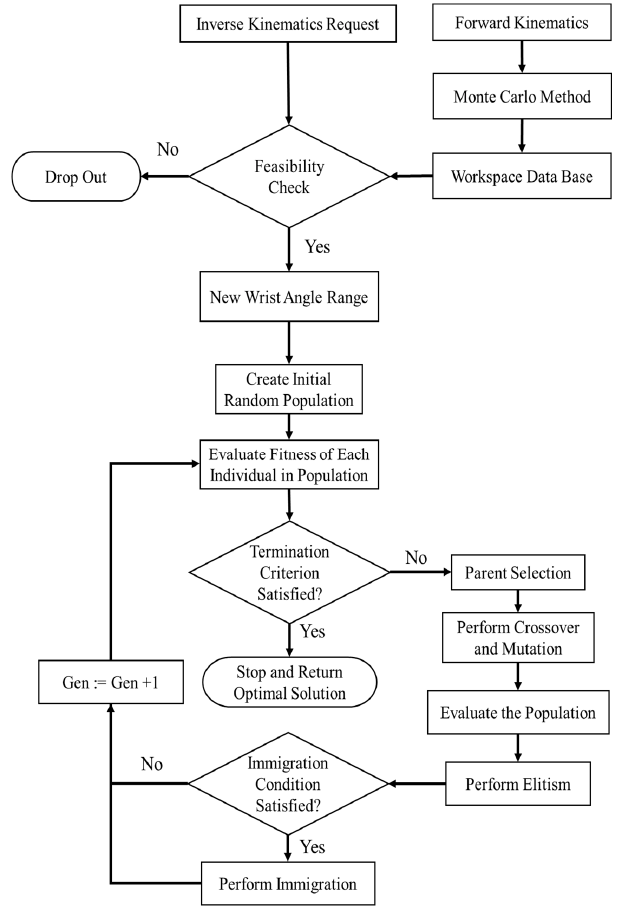
Figure 4. Flowchart of the proposed algorithm.